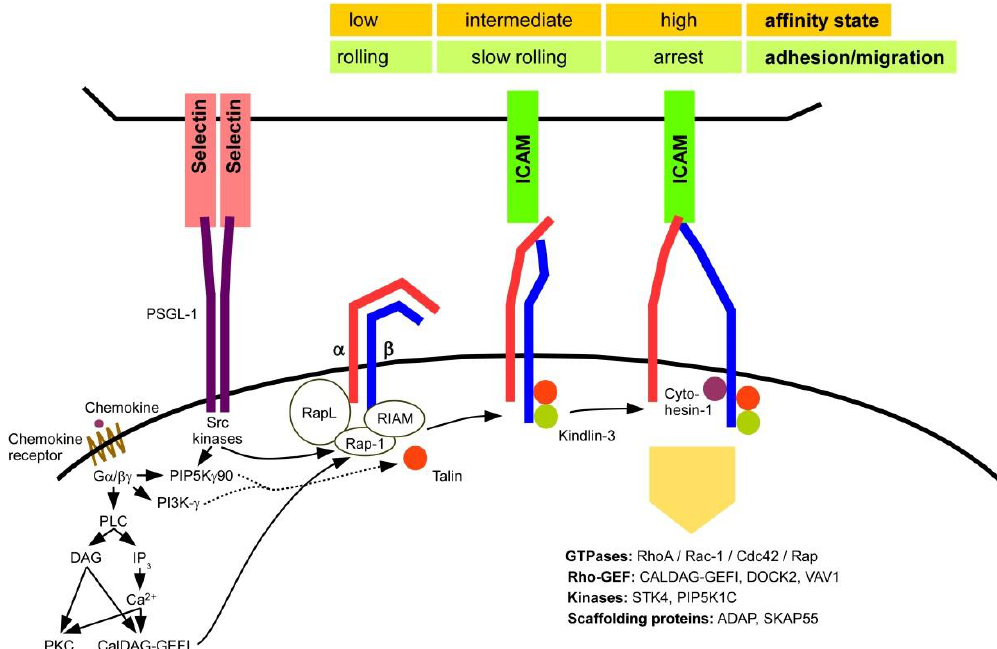
Figure 4 . Regulation of β 2 integrin inside-out signaling. Activation of signaling adaptor proteins and β 2 integrin-binding proteins in response to engagement of chemokine receptors and PSGL-1 is indicated by arrows.